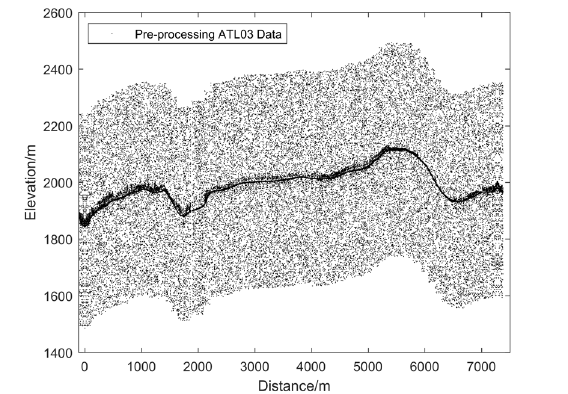
Figure 6. Pre-processing ATL03 photon data.